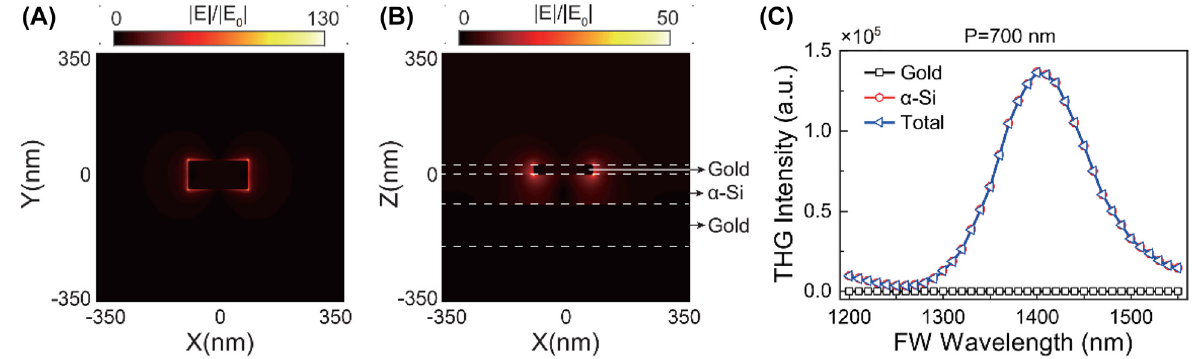
Figure 5: Calculated field distributions of the H-polarized FW and the THG contributions from gold and α -Si. (A) The calculated electric field distribution at the interface of gold meta-atomand the α -Si film. (B) The calculated electric field distribution in the X – Z plane( y =0).Thefundamentalwavelengthin(A)and(B)is λ =1404nm.(C)ThecalculatedwavelengthdependentTHGintensitiesofthe gold/ α -Si hybrid